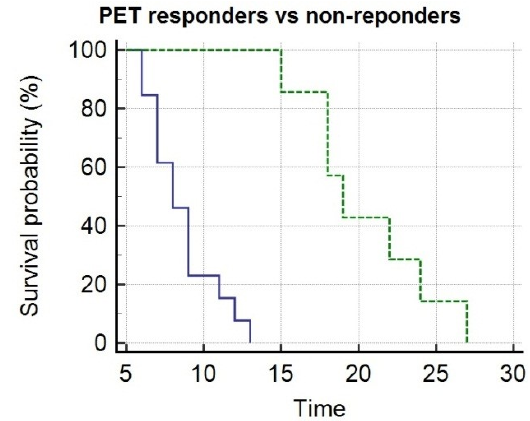
Figure 3. Kaplan–Meier analysis depicts overall survival after 223 Ra-therapy as function of metabolic response assessed at post treatment PET/CT with 18 F-choline. PET responders (green line) presented significantly longer survival as compared with non-responders (blue line).